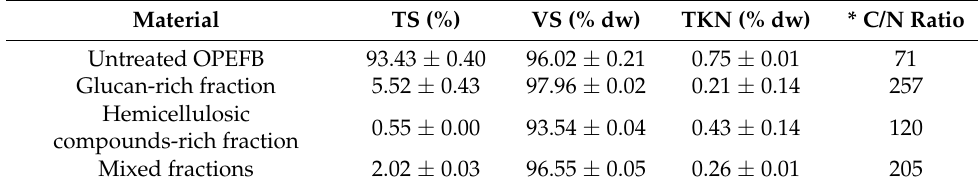
Table 1. The total solid (TS), volatile solids (VS), and nitrogen (TKN) contents of untreated OPEFB and organosolv pretreatment-derived OPEFB